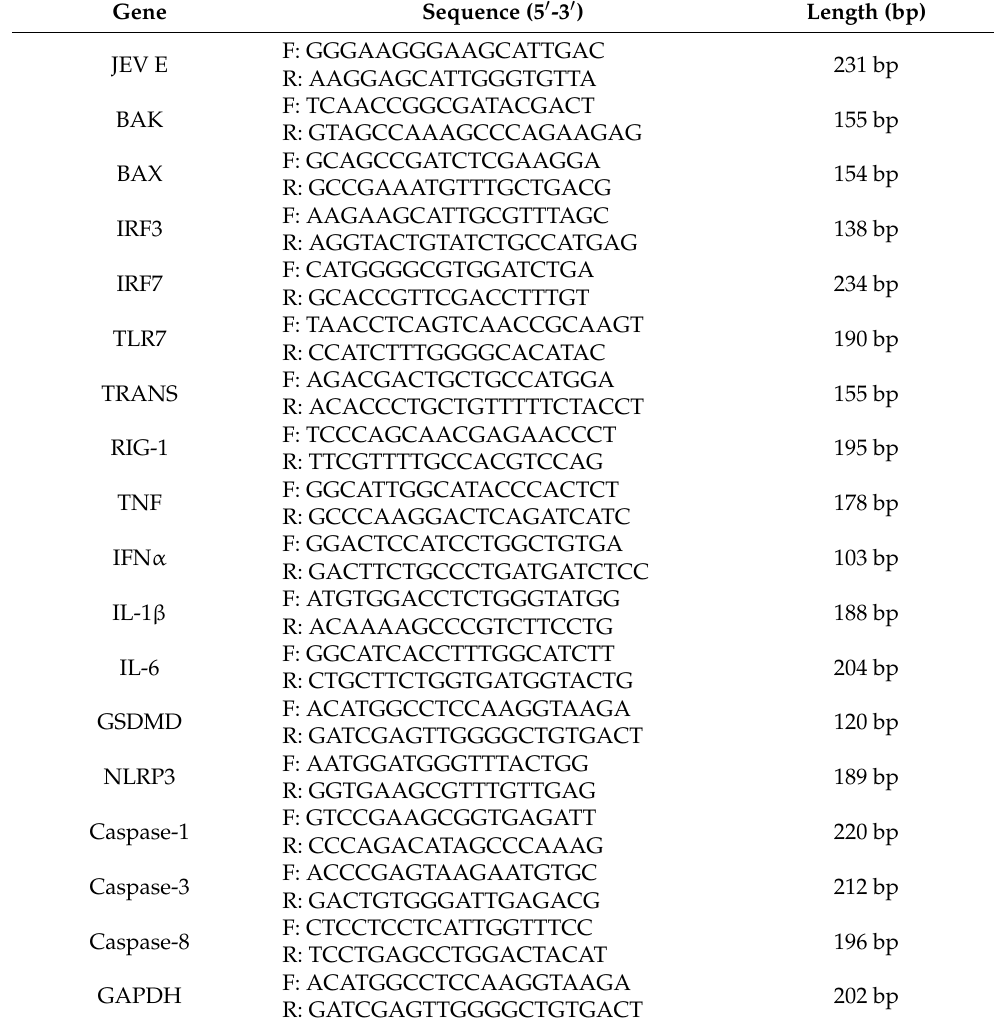
Table 2. Primers used for